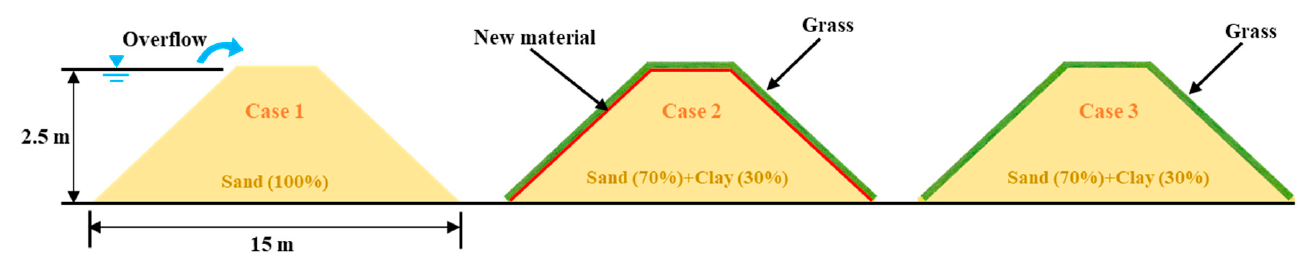
Figure 1. Specifications of the hydraulic experiment model and experimental conditions.